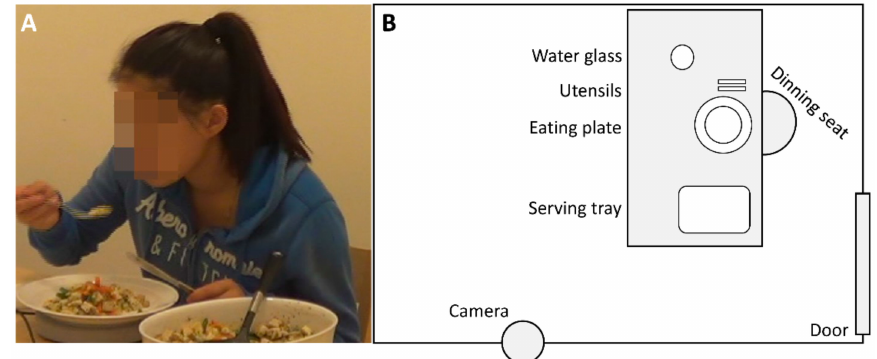
Figure 3. ( A ) Screenshot from an experimental meal video. ( B ) A schematic representation of the experimental dining room. The subjects were free to change the placement of the items on the table